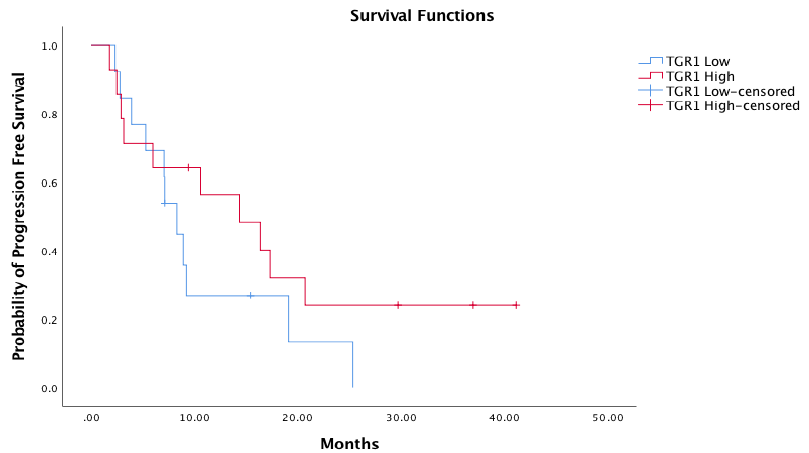
Figure 2. Correlation between TGR1 and PFS. TGR1 low: TGR1 lower than the median. TGR1 high: TGR1 higher than the